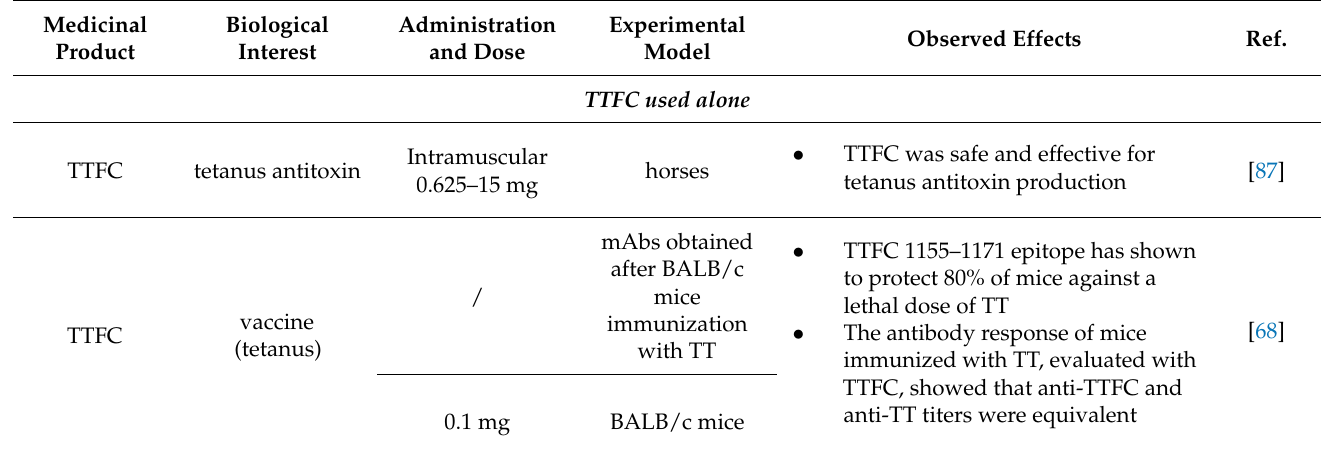
Table 3. Non-exhaustive list of in vivo uses of TTFC for vaccine applications between 2009 and